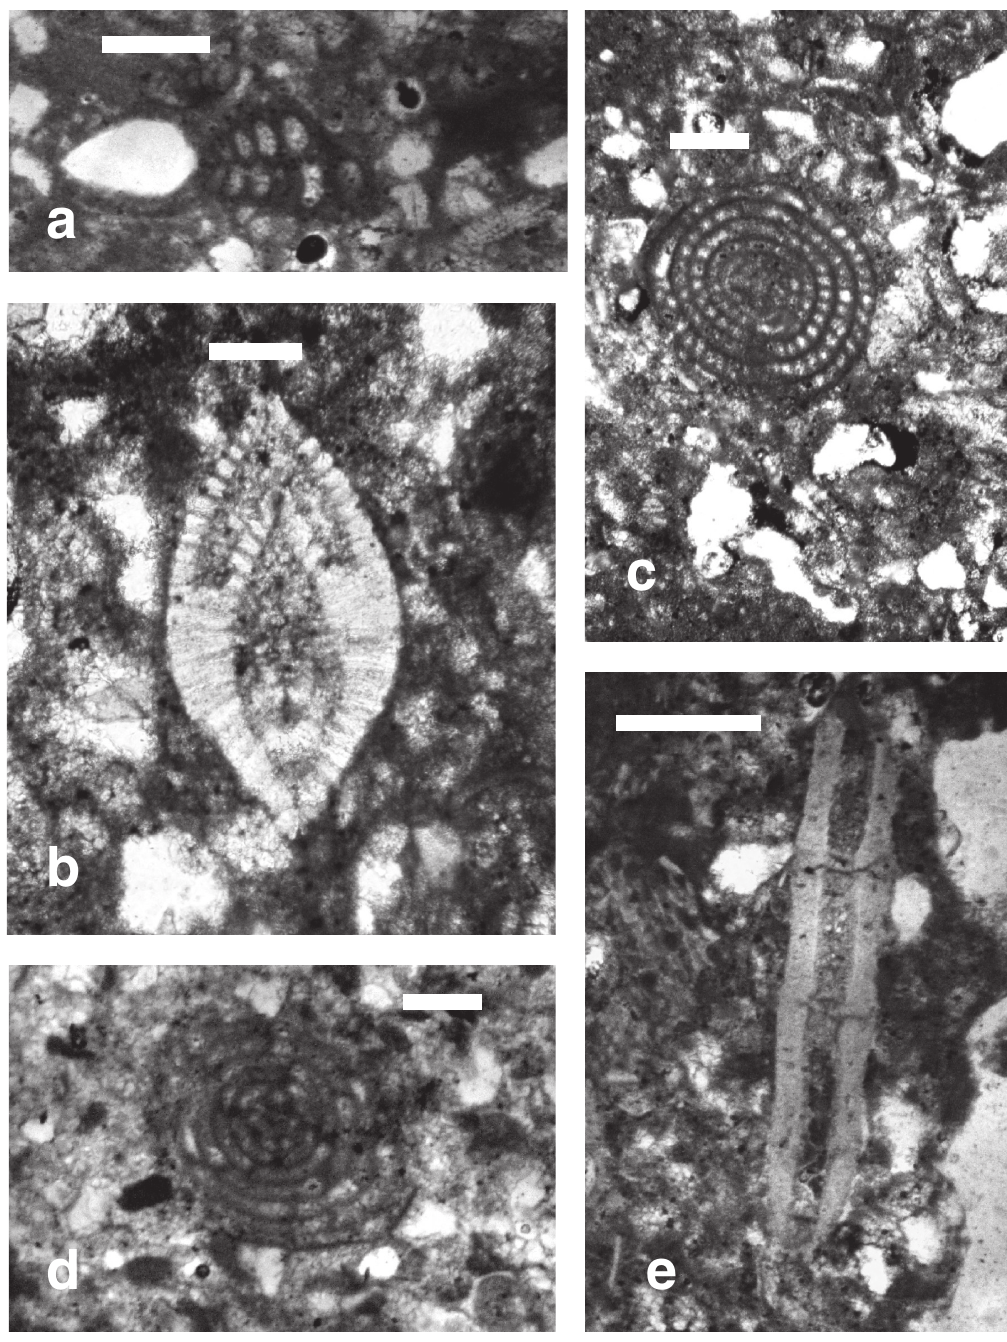
scale bars: a = 0.3 mm; b–e = 0.5 mm. a. Textularia sp., G1. b. Elphidium sp., sample G1. c,d. Borelis sp., G2. e. Fragment of Operculina sp., sample